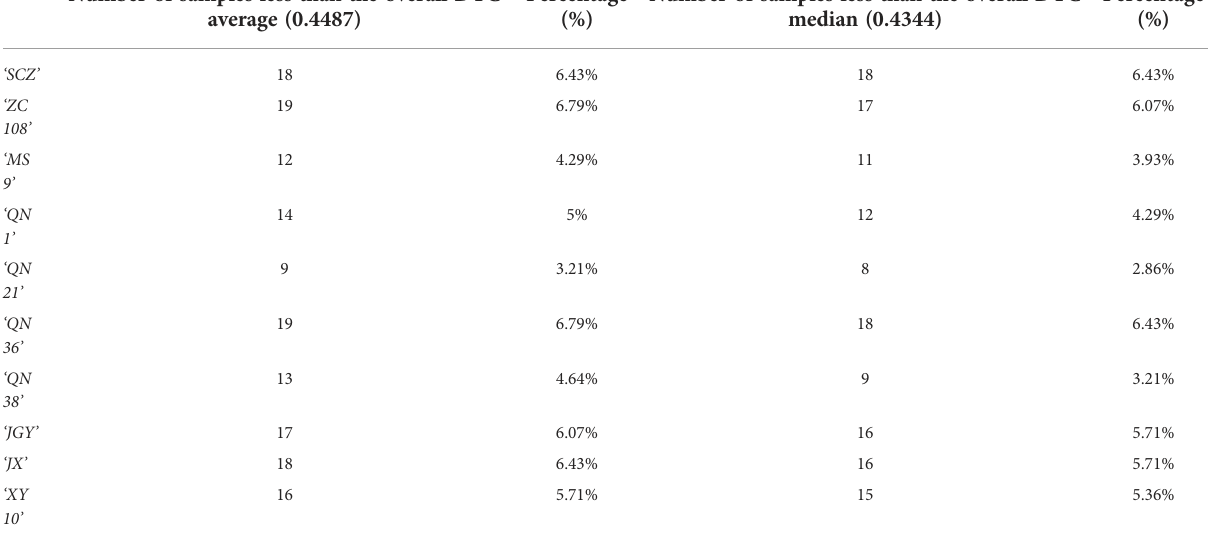
TABLE 2 Proportion of DTC of different tea germplasm resources in all tested individuals. Number of samples less than the overall DTC average (0.4487)